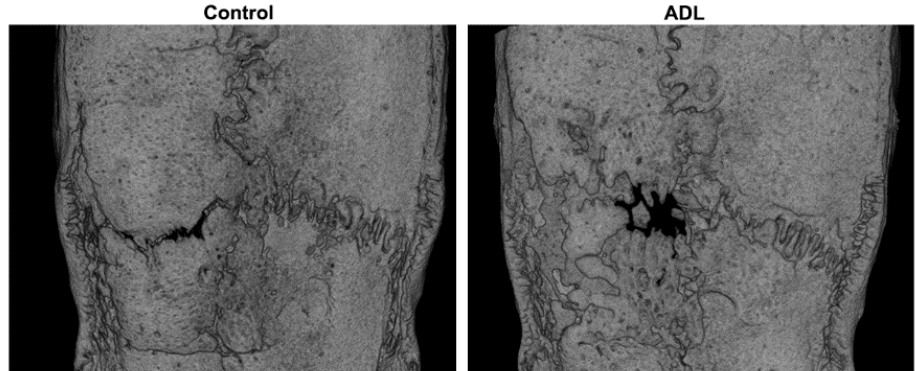
Figure 1. Micro-CT overview of the defect anatomy shows almost complete coverage after four weeks of healing. Rat calvaria defects with opening of the sutures were covered with a collagen membrane either soaked in serum-free medium ( Control ), or in acid dentin lysates ( ADL ). The images represent the specimens with a median defect coverage.